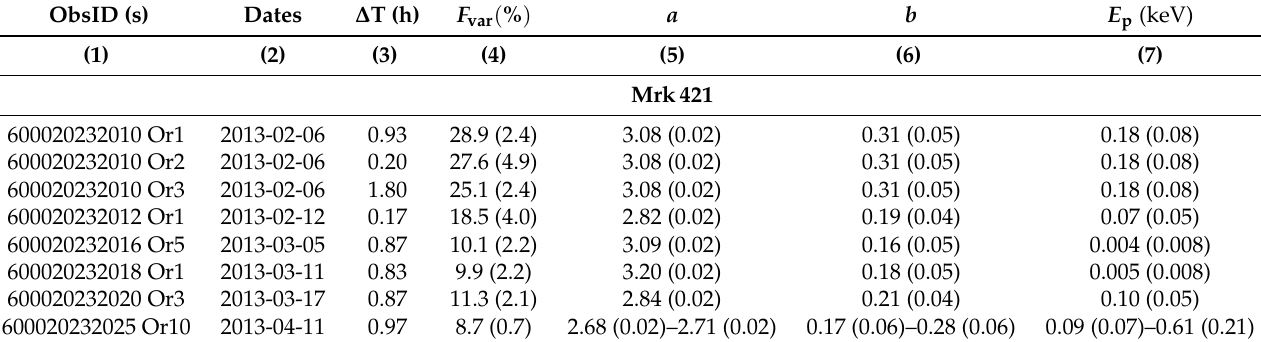
Table 3. Summary of the 3–79 keV IDVs observed in Mrk421 with NuSTAR. In Column (1), “Or” stands for “Orbit”. The third column gives the total length of the particular observation; Columns (5)–(7) give the ranges of the photon index, the curvature parameter and the position of the synchrotron SED